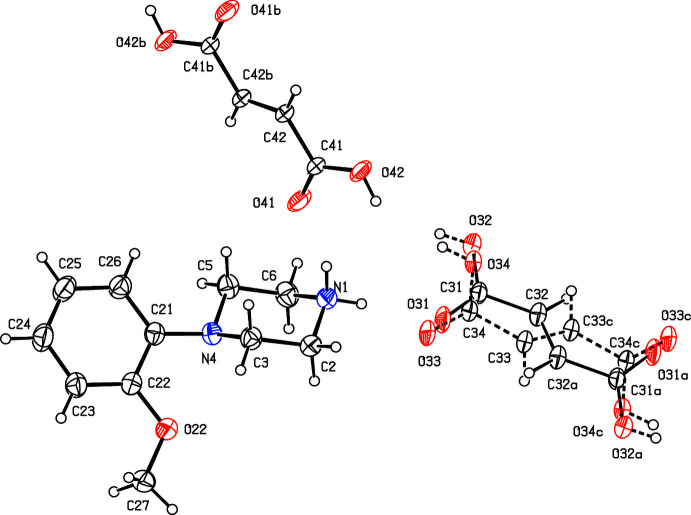
The independent components of compound (XIV) showing the atom-labelling scheme and the disorder in one of the anions. The major disorder component is drawn using full lines and the minor disorder component is drawn using broken lines. Displacement ellipsoids are drawn at the 30% probability level. The atoms marked ‘a’ or ‘b’ are at the symmetry positions (2 − x, 1 − y, 2 − z) and (−x, −y, 2 − z), respectively. The H atoms bonded to atoms O32, O34 and O42 have occupancies 0.286 (9), 0.214 (9) and 0.5, respectively, as do their inversion-related equivalents.